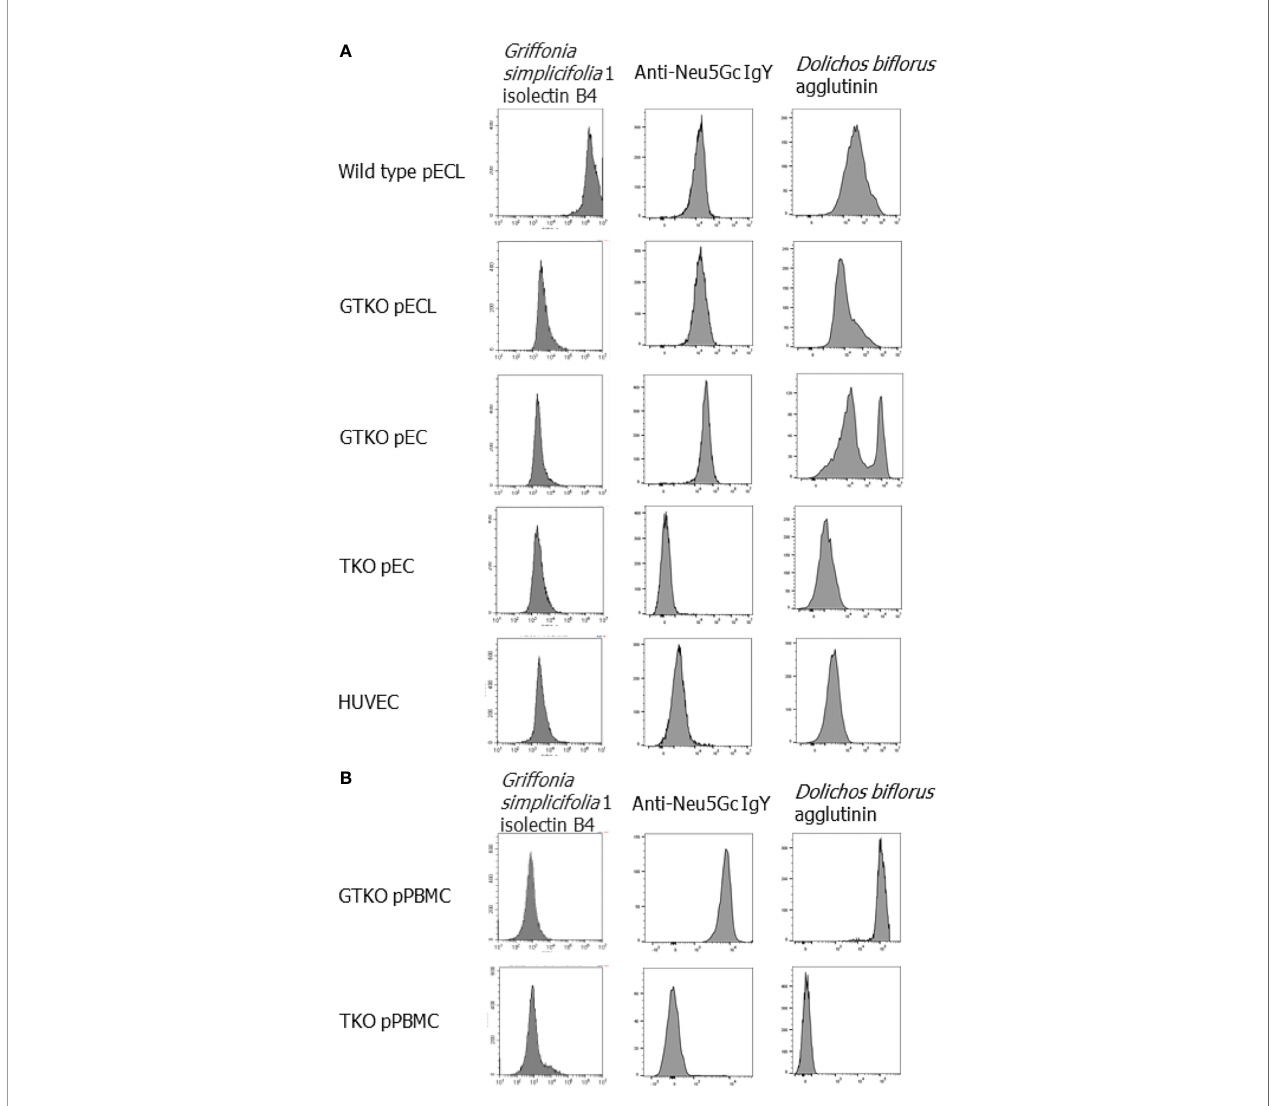
FIGURE 1 | Phenotypes of genetically modi fi ed porcine cells. The expression of Gal, Neu5Gc and Sd(a) on the cells was visualized by stain with fl uorescein-conjugated Griffonia simplicifolia 1 isolectin B4, anti-Neu5Gc IgY paired with Alexa 647-conjugated anti-chicken IgY and Dolichos bi fl orus agglutinin fl uorescein, respectively, and then analyzed by fl ow cytometry. Endothelial cells, including wild-type and alpha-1,3-galactosyltransferase gene-knockout ( GT KO) porcine endothelial cell lines (pECL), primary porcine endothelial cells (pEC) from GT KO pigs and from triple knockout (TKO) pigs, human umbilical vein cells (HUVEC) (A) , and porcine peripheral blood mononuclear cells (pPBMC) from GT KO pigs and from triple knockout (TKO) pigs (B) were used in the